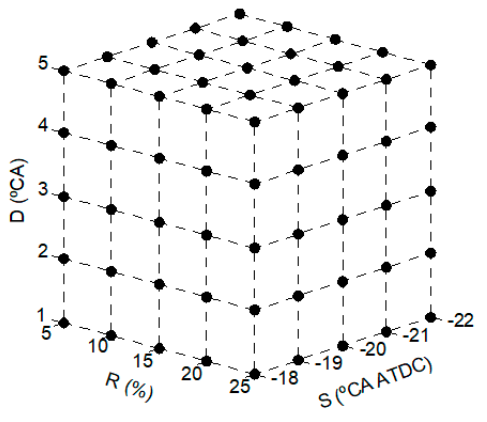
Figure 3. Illustration of the 125 cases analyzed.